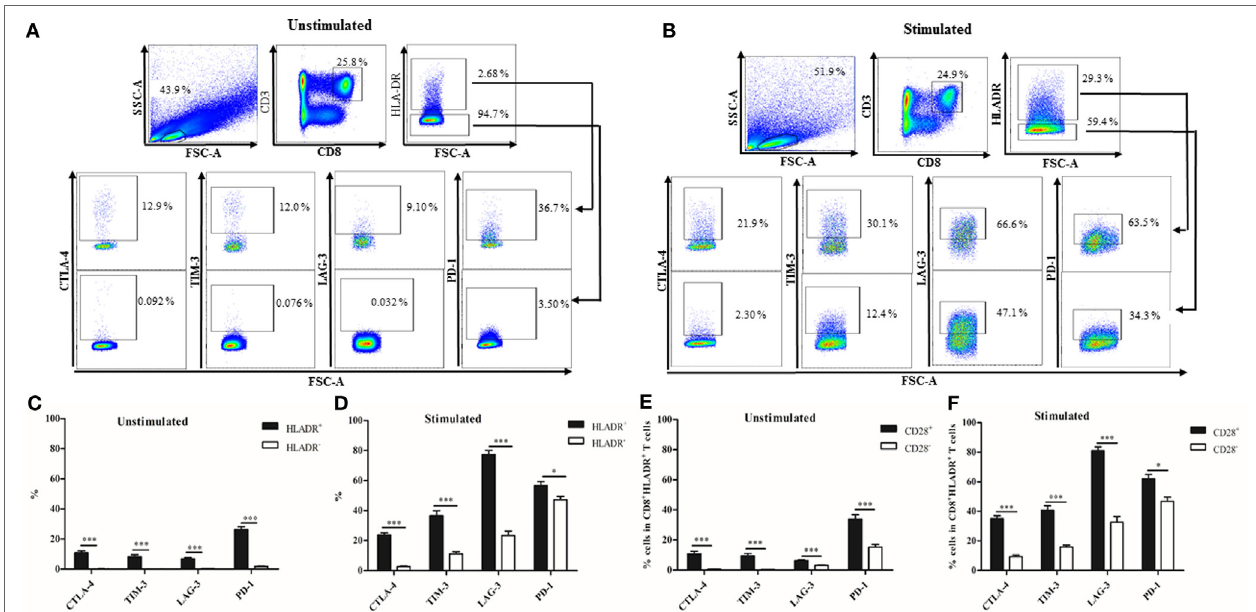
FigUre 3 | Expression of checkpoint inhibitory molecules on CD8 + human leukocyte antigen–antigen D related (HLADR) + and on CD8 + HLADR − T cells. (a) Representative FACS plots of inhibitory molecules in the CD8 + HLADR + (upper panel) and the CD8 + HLADR − population (lower panel) using cells from a young donor. (b) Representative FACS plots of inhibitory molecules in the CD8 + HLADR + and the CD8 + HLADR − population using cells from a young donor following stimulation with anti-CD3 (1 µg/ml) and anti-CD28 (0.5 µg/ml) for 24 h. (c) Expression of checkpoint inhibitory molecules in CD8 + HLADR + vs CD8 + HLADR − T cells in unstimulated cells; young donors n = 22 ( < 30 years), mean ± SEM, *** p < 0.0001. (D) Expression of checkpoint inhibitory molecules in CD8 + HLADR + vs CD8 + HLADR − T cells following stimulation; young donors n = 9 ( < 30 years), mean ± SEM, *** p < 0.0001, * p < 0.05. (e) Expression of checkpoint inhibitory molecules in CD8 + HLADR + CD28 + vs CD8 + HLADR + CD28 − T cells in unstimulated cells; young donors n = 22 ( < 30 years), mean ± SEM, *** p < 0.0001. (F) Expression of checkpoint inhibitory molecules CD8 + HLADR + CD28 + vs CD8 + HLADR + CD28 − T cells following stimulation; young donors n = 9 ( < 30 years), mean ± SEM, *** p < 0.0001, * p <